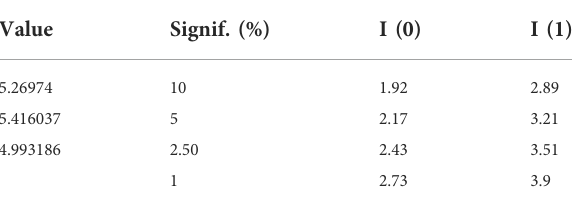
TABLE 6 Bound test results. F-bound